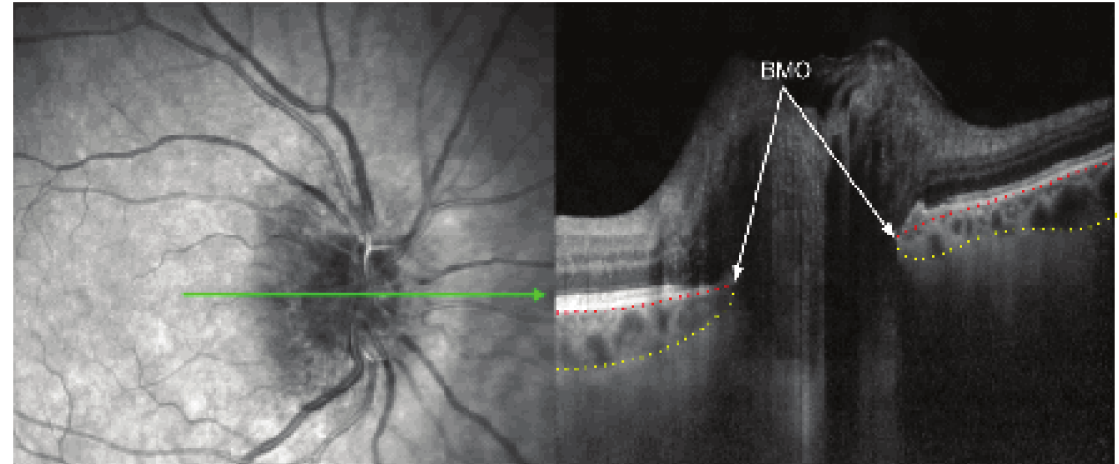
Figure 1. Delineated SD-OCT from affected eye: Bruch’s membrane (dotted red line), anterior sclera (dotted yellow line), BMO, Bruch’s membrane opening.